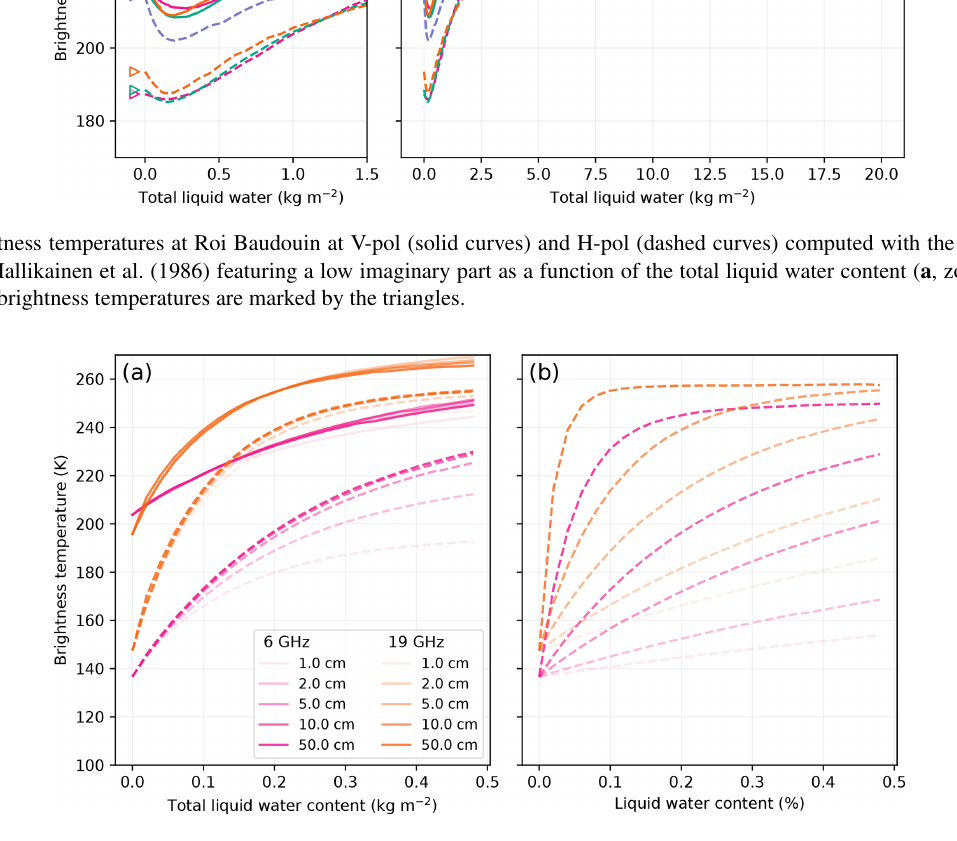
Figure 10. Brightness temperature as a function of the total liquid water content (a) and the volumetric liquid water content (b) for various wet snow layer thickness, for Roi Baudouin at 6GHz (pink) and 19GHz (orange), at V-pol (solid curves) and H-pol (dashed curves). V-pol is not on panel (b) for the sake of